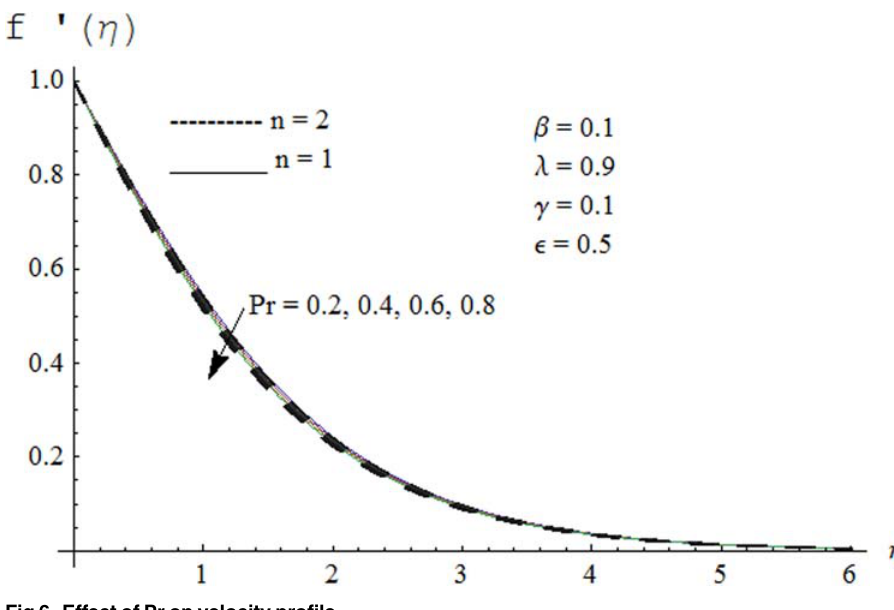
Fig 6. Effect of Pr on velocity profile.